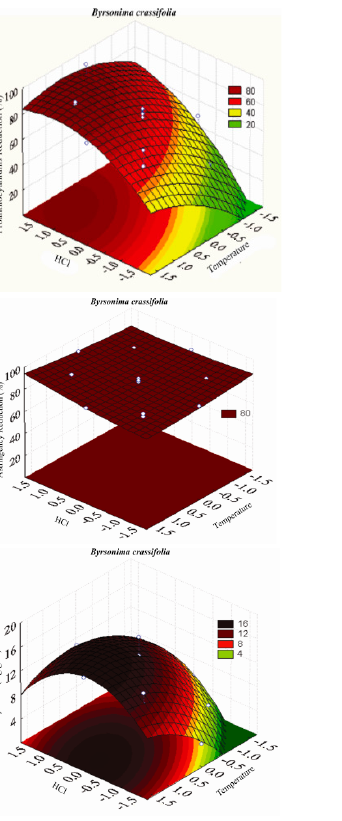
Figure 1. Response surface and contour line for proanthocyanidin reduction, astringency reduction, and cyanidin content in B. crassifolia , E. oleracea , and I. edulis